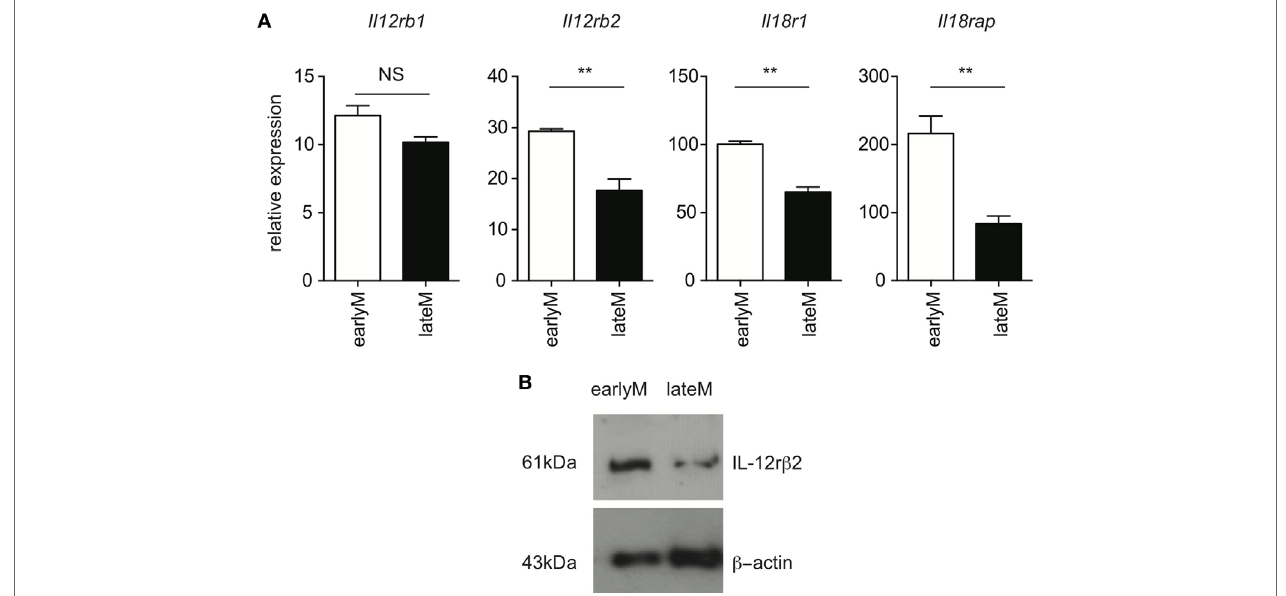
FigUre 3 | Expression of components of the IL-12 and IL-18 receptors decreases with time after initial antigen encounter. Mice received adoptive transfer of naïve P14 cells and were infected with LCMV-Armstrong. Either 30 days (earlyM) or > 8 months (lateM) after LCMV infection, splenocytes were sorted. (a) Summary bar graphs of relative expression of Il12rb 1, Il12rb2 , Il18r1 , and Il18rap based on qRT-PCR for earlyM or lateM P14 cells. n = 3 mice per group. Representative data from 1 of 2 independent experiments. Error bars represent mean ± SEM. Unpaired t -test; NS, not significant, ** p < 0.01. (B) Western blot image of expression of IL-12r β 2 for earlyM and lateM P14 cells. P14 cells were sorted from three separate mice and combined. Representative image from one of two independent experiments with similar